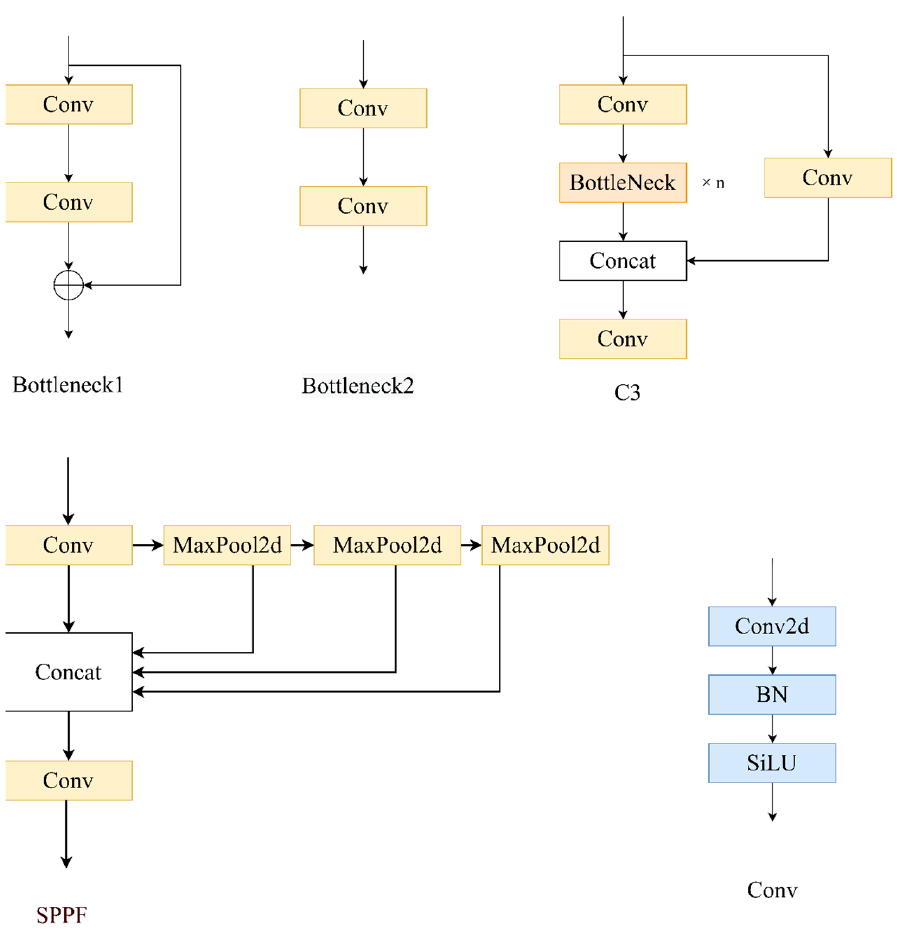
Figure 2. Main module of YOLOv5.